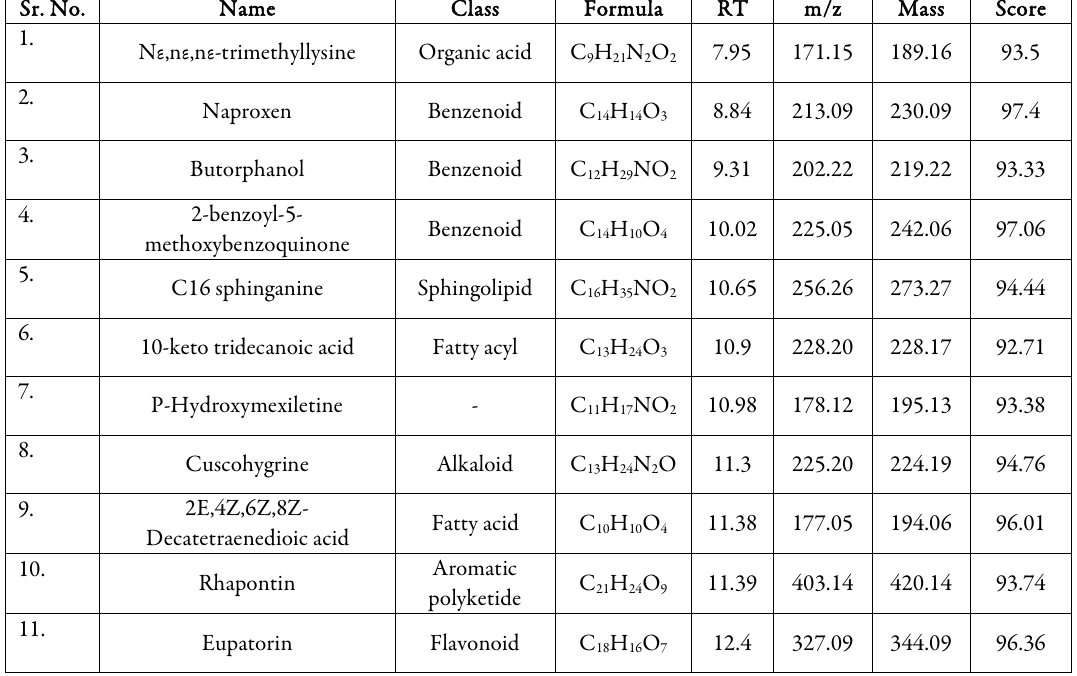
Table 3. Compounds detected in the acetone solution of 9 th TLC band of R-Ac extract of A. aspera Sr.